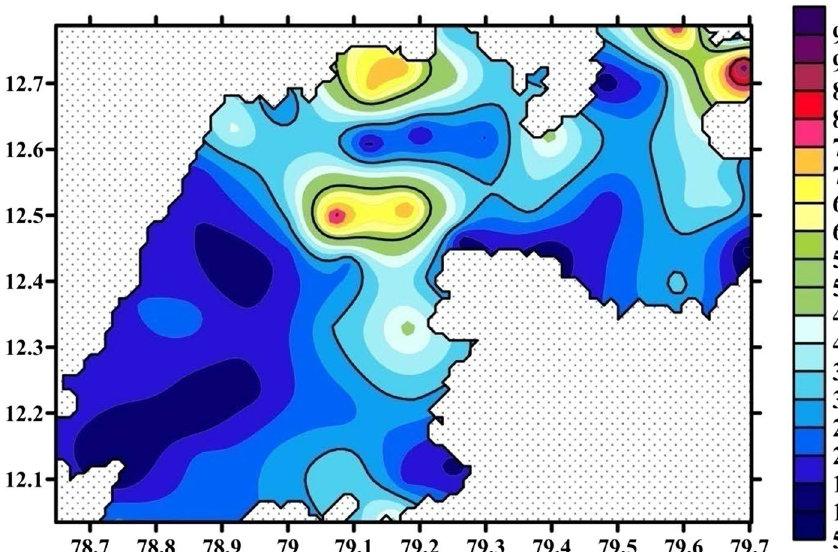
Fig. 8 Spatial distribution of EC